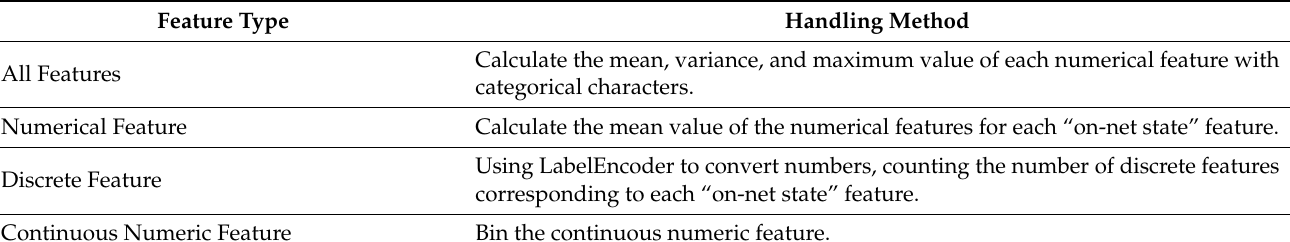
Table 1. Feature engineering